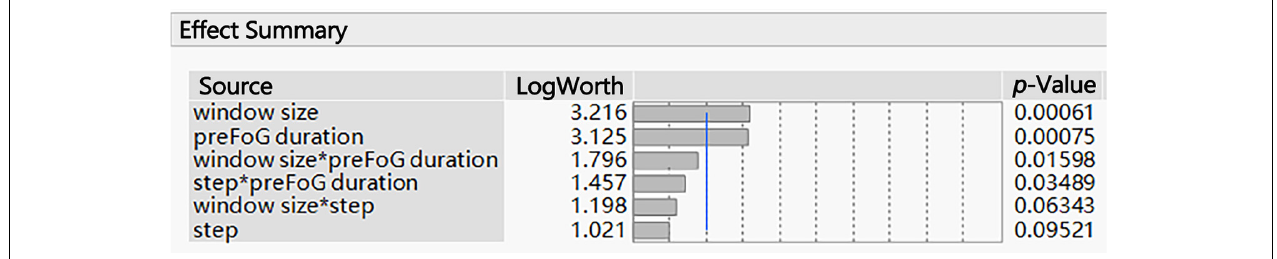
FIGURE 6 | Summary of the effects of the feature extraction parameters on the F1 score. The p -values show the statistical significance of the association between the parameters and the F1 score. *Multiplication.